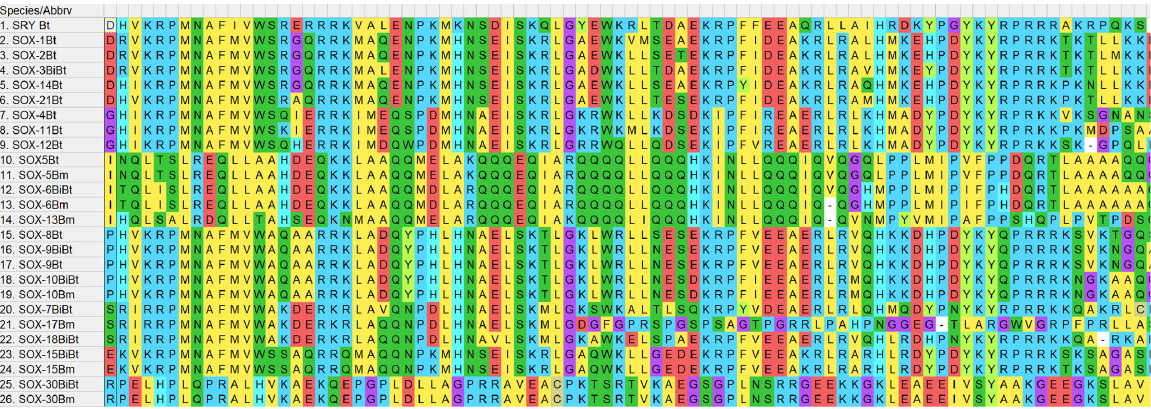
Figure 2. Multiple sequence alignment of Sox genes in Bos sp. (SRY: Sex-determining region Y, Bt: Bos taurus, BiBt: Bos indicus x Bos tautus, and Bm: Bos mutus. Colors were assigned by MEGA software based on the biochemical properties of the amino acids. Red, acidic; yellow, non ‐ polar neutral; cyan, positive polar basic; blue, positive polar; green, neutral polar; purple, neutral non ‐ polar; lime, neutral polar).